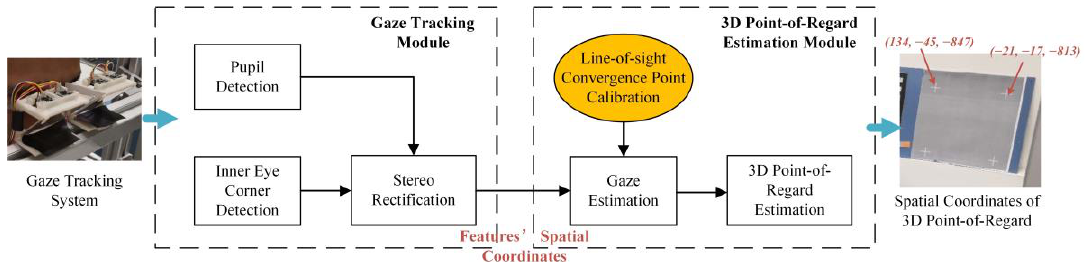
Figure 1. The architecture of the 3D Point-of-Regard estimation method.